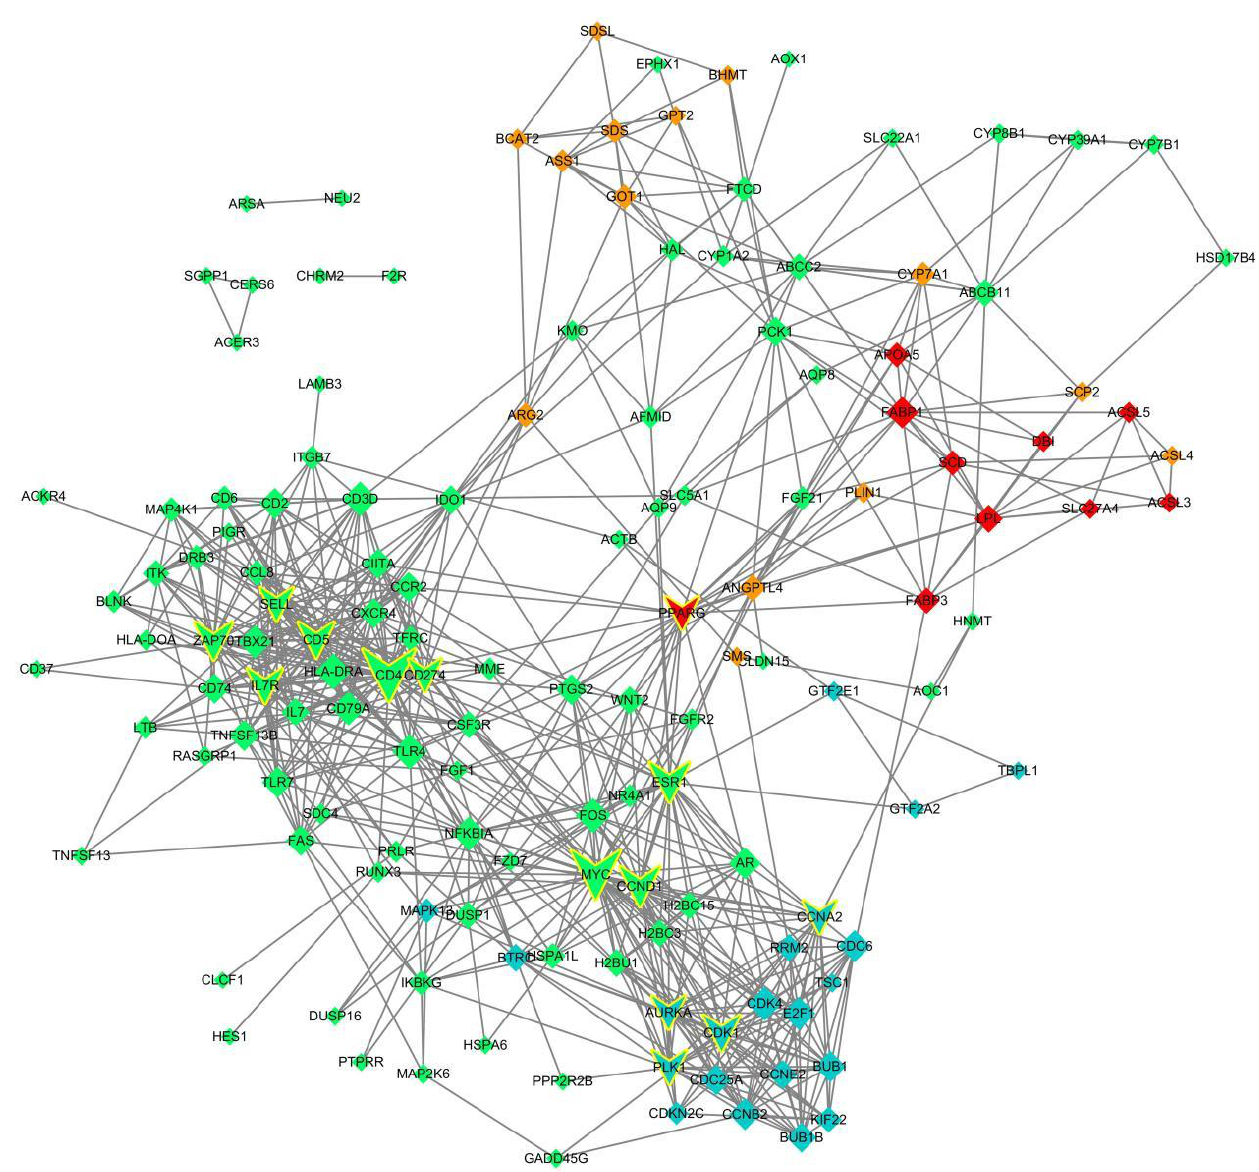
Figure 3. Protein–protein interaction networks of the KEGG pathway significantly enriched genes. Red indicates genes in cluster 1; orange indicates genes in cluster 2; blue indicates genes in cluster 3; green indicates genes associated with cluster 4; those with yellow boxes indicate key genes.